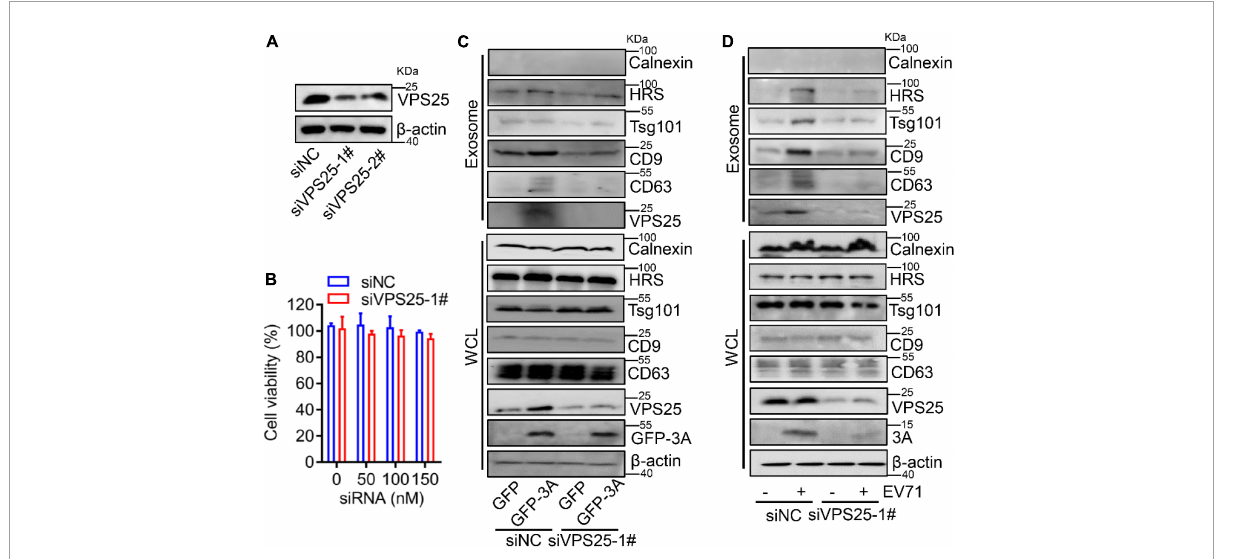
FIGURE5 Vacuolar protein sorting 25 (VPS25) mediates EV71-induced exosome biogenesis. (A,B) RD cells were transfected with 100 nM siRNA negative control (siNC), or against VPS25 (siVPS25-1#, -2#), respectively. At 48 h post-transfection, the level of VPS25 protein was measured by Western blot (A) . Until 72 h post-transfection, the cell viability was measured using the CCK8 assay (B) . (C,D) RD cells were transfected with siNC or siVPS25-1# for 24 h and then transfected with plasmids expressing GFP or GFP-tagged 3A (C) , or infected with EV71 (MOI = 0.5) (D) for another 24 h. The extracted exosomes and cell lysates were analyzed by Western blot. The equal volume of exosomes in PBS of each sample with a total protein amount ranging from 0.5 to 2.0 µ g was loaded. WCL, whole cell